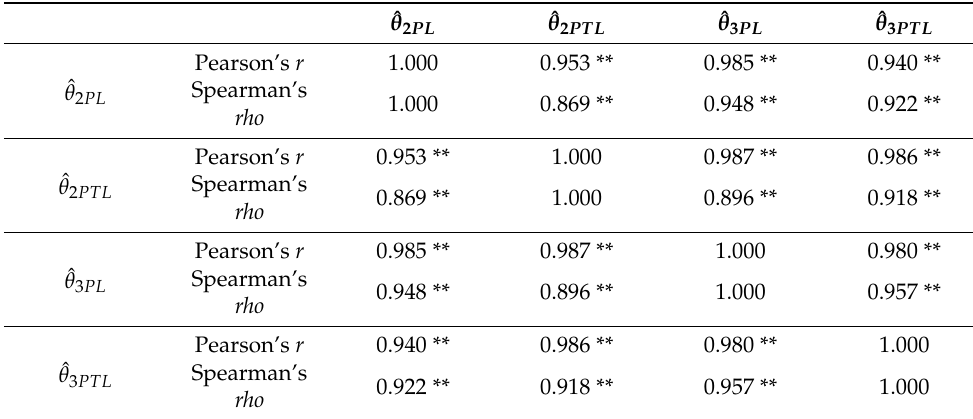
Table 6. Correlation Table of the LSAT Data Person Parameter